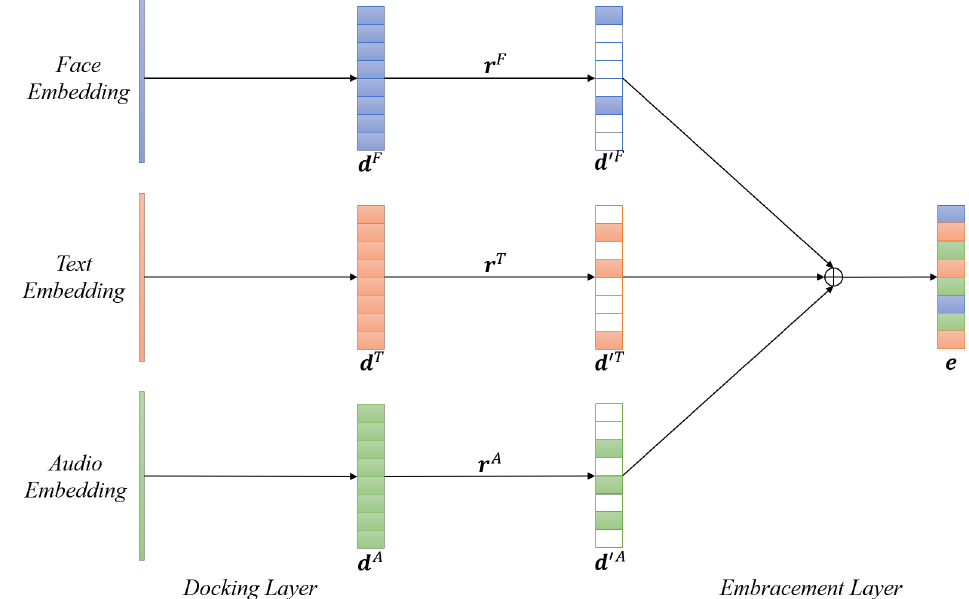
Figure 6. The EmbraceNet for multimodal